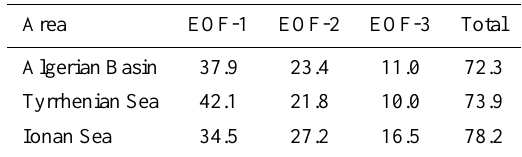
Table 1. Variance fraction (in %) explained by the first three bi- variate EOFs in three different areas of the Mediterranean Sea for the spring season